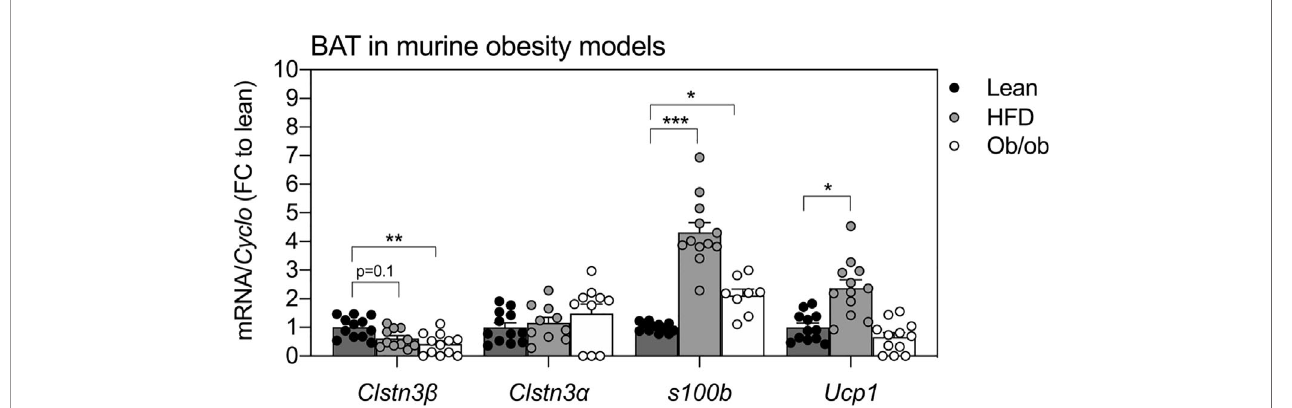
FIGURE 3 | Expression patterns of Clstn3 b in mouse models of obesity. Gene expression of Clstn3 b , Clsnt3 a , S100b and Ucp1 in brown adipose tissue from lean, high-fat diet (HFD) fed or ob/ob mice (n = 11 – 12 mice per condition). Data represent means ± SEM, expressed relative to lean controls. One-way-ANOVA and post- hoc comparisons between groups are indicated in graphs. Asterisks: *p < 0.05, **p < 0.01, ***p <